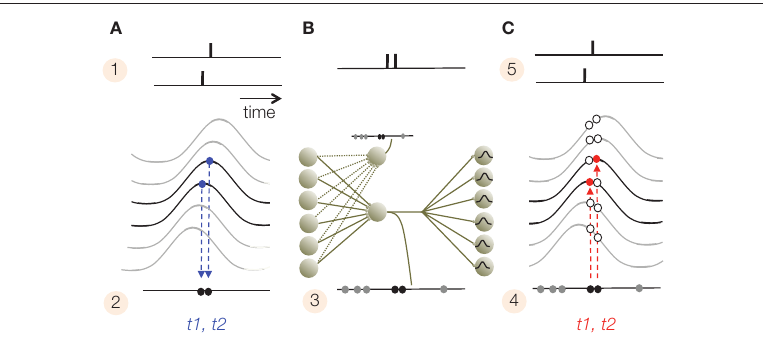
Figure 2 | interference principle. (A) The top panel illustrates the times of two APs generated by two adjacent neurons (1) after their alignments to the intracellular SMO (2). Because the only APs that survive are the ones that coincide with the peak of SMO, the propagating oscillation will convert the spatial distance between the two neurons into a slight delay ( t1 , t2 ) between the two APs (2). (B) At the transfer stage, due to convergent and divergent synaptic connections, APs from a subset of neurons will merge on a set of projection neurons with low thresholds. Projection neurons sharing input from the same pool will replicate the same compressed AP train (3). (C) The compressed code projects to a large pool of target neurons. Since target neurons have a similar propagating SMO, the projected APs will generate a new AP only on neurons where the AP precisely coincides with the SMO peak (4). This is the interference principle. The red circles represent these coincidences, while open circles are the mismatches. As a result, the APs pattern ( t1 , t2 ) recovered the original input pattern from